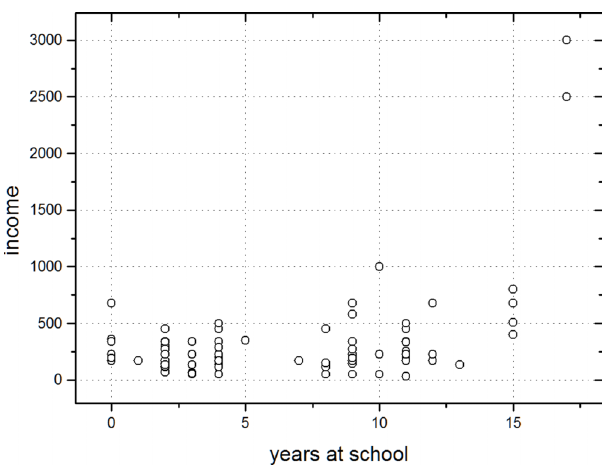
Figure 1 - Patient distribution according to their income and years of formal education. Spearman ’ s rank order correlation was significant between the two variables: r = 0.20; p =